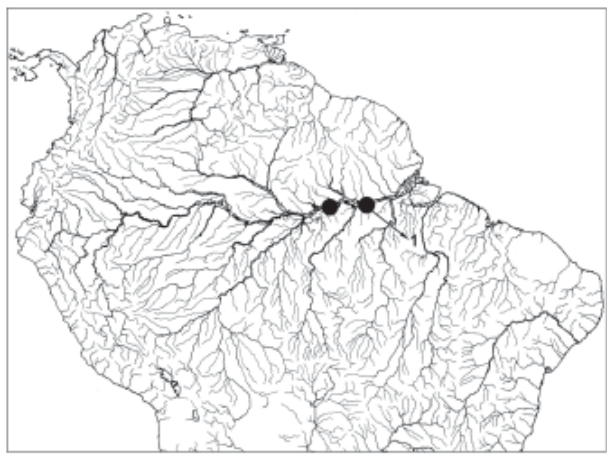
Fig 3. Distribution of Entomocorus melaphareus. Type locality is indicated by the number 1.